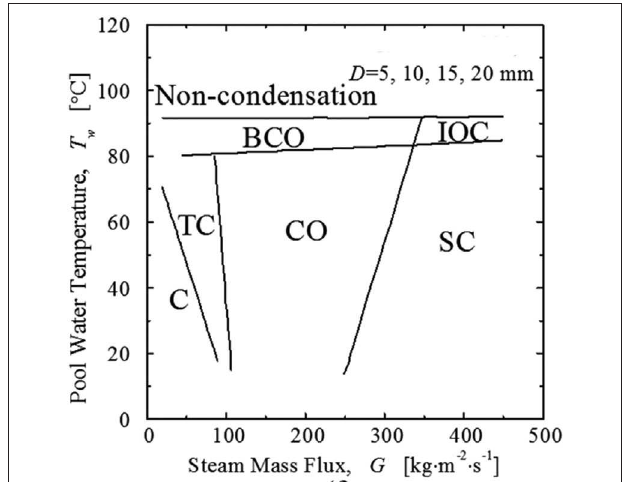
FIGURE 5 | The regime map developed by Cho et al. (1998).